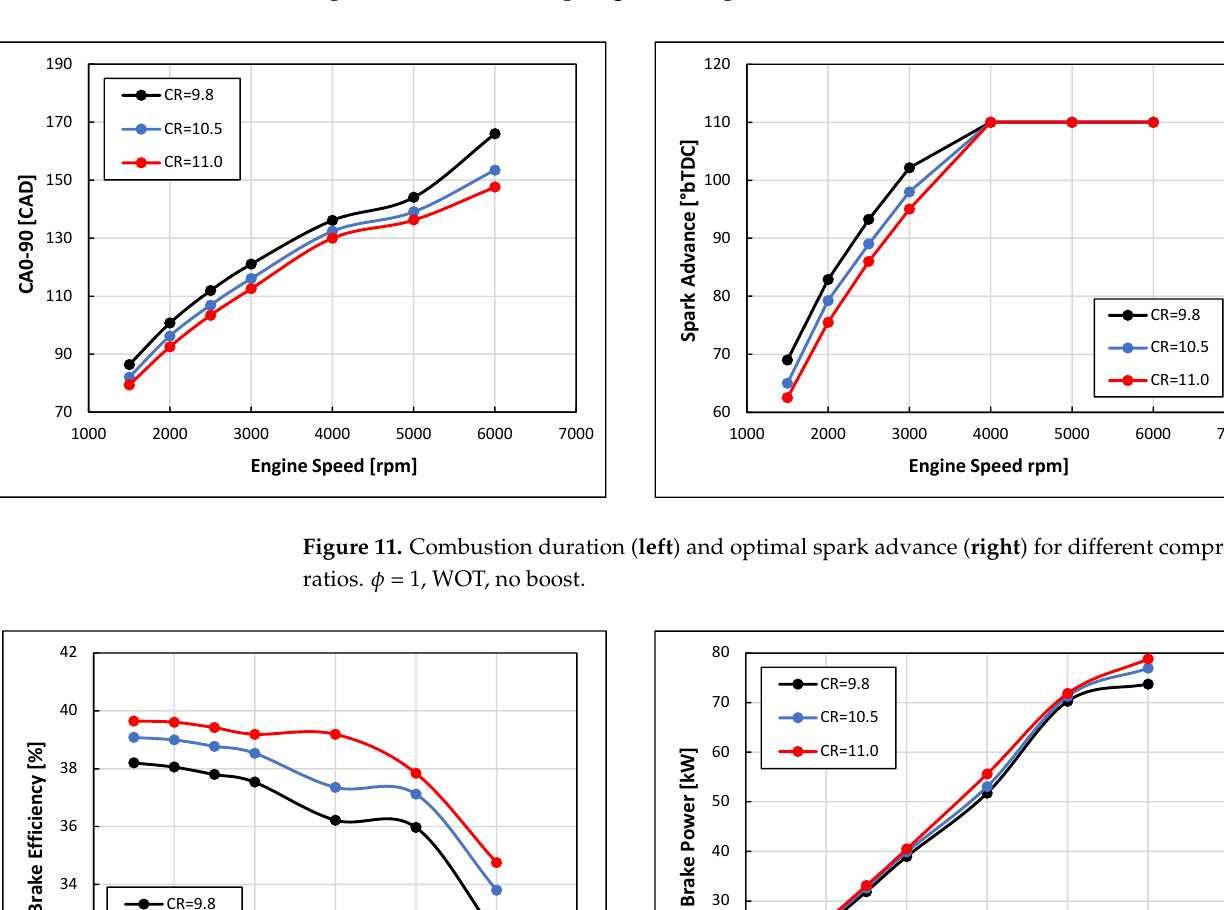
Figure 13. BSFC ( left ) and burned fuel fraction ( right ) for different compression ratios. ϕ = 1, WOT, no boost.